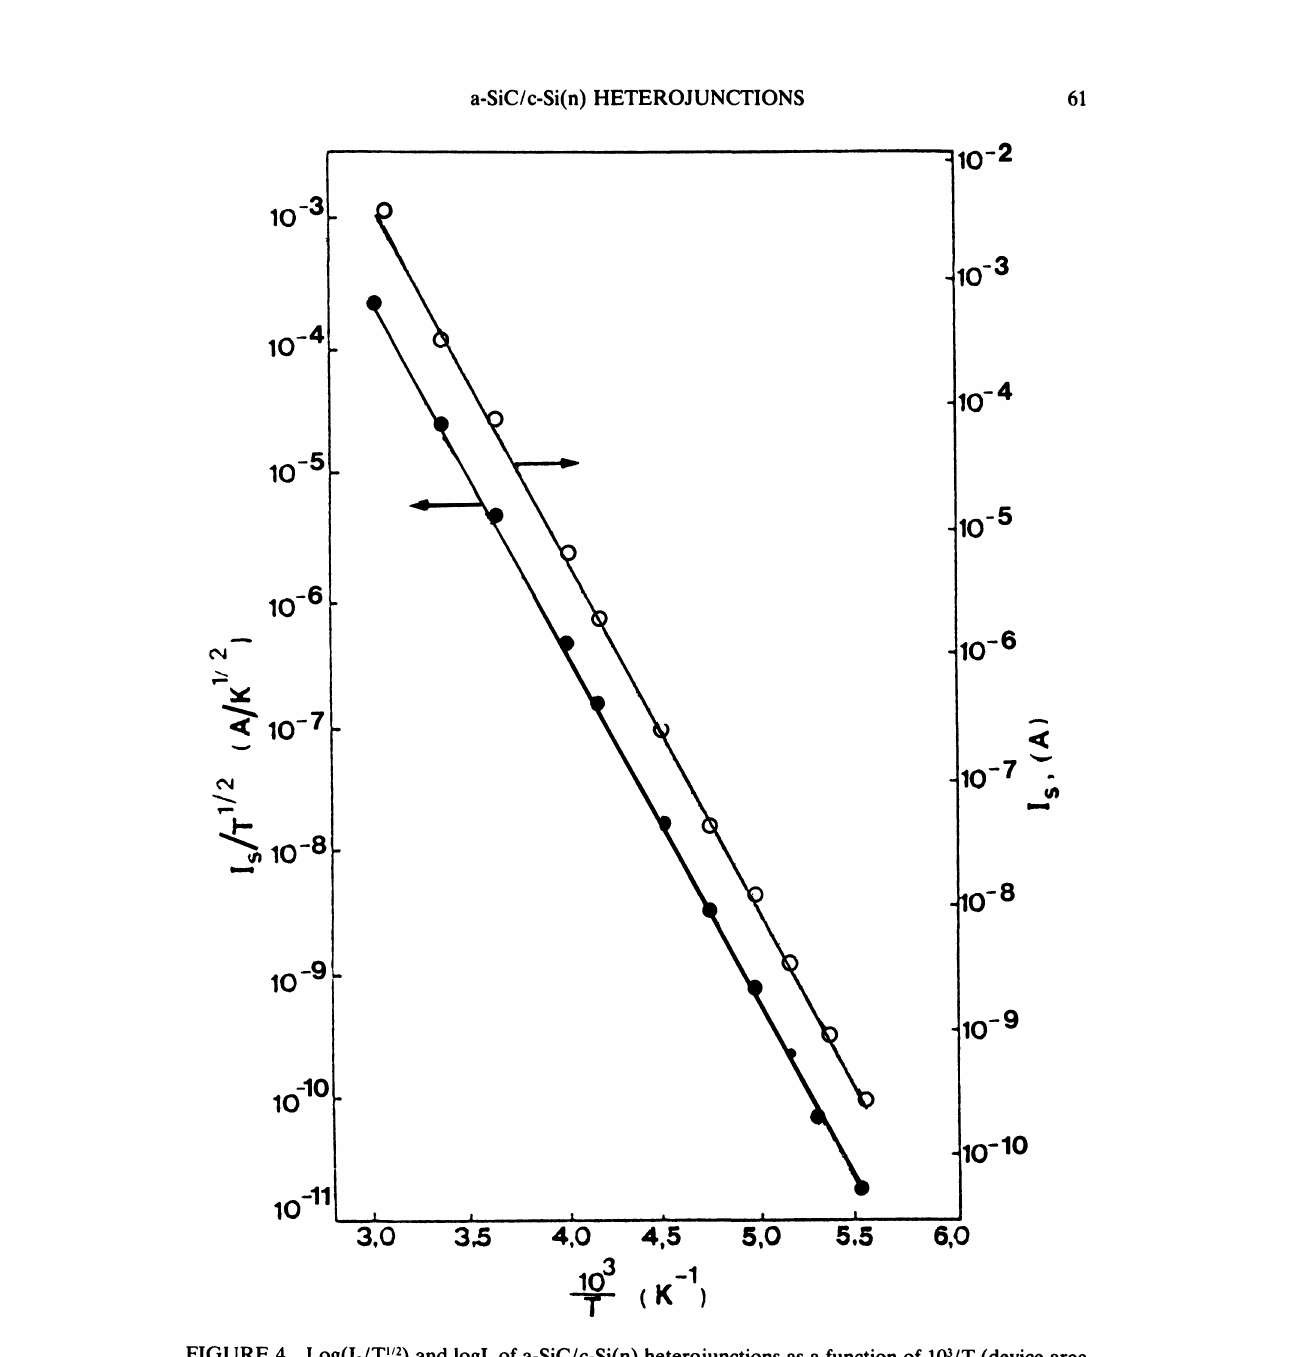
FIGURE 4 Log(Is/T /2) and iogIs of a-SiC/c-Si(n) heterojunctions as a function of 103/T (device area 0.785